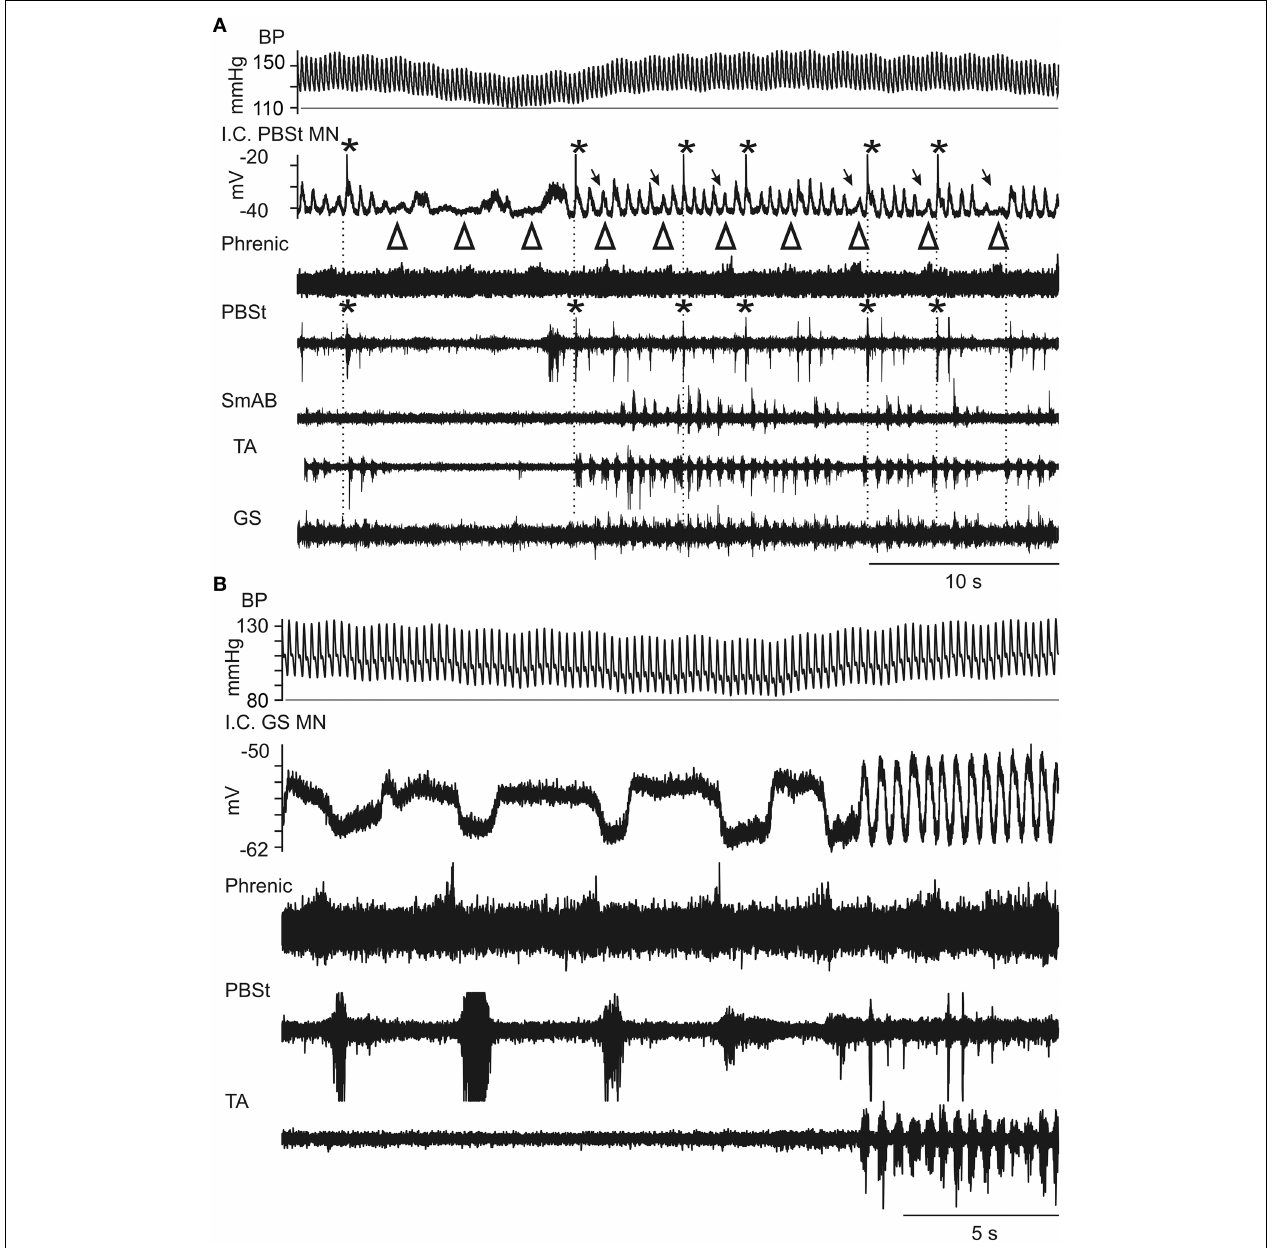
FIGURE 4 | Expanded records of Mayer wave-initiated locomotor-like activity during intracellular recording from two motoneurons. (A) From a PBST motoneuron. The largest bursts in the PBSt nerve occurred in the post-inspiratory phase of respiration, corresponding to the largest depolarizations of the LDP in a PBSt motoneuron (asterisks for both). These depolarizations often elicited spikes (truncated). During inspiration, indicated by open arrowheads above the phrenic recording (whose discharge appears weak, most likely a recording problem), there was a decreased amplitude of the LDP (arrows). Between the episodes of locomotor-like activity, the respiratory drive was evident as a CRDP in the PBSt motoneuron, consisting of rather variable depolarization in post-inspiration (arrowheads), and with a corresponding weak discharge, just detectable in the PBSt nerve. The prolonged depolarization visible in the intracellular record following the third arrowhead corresponds to